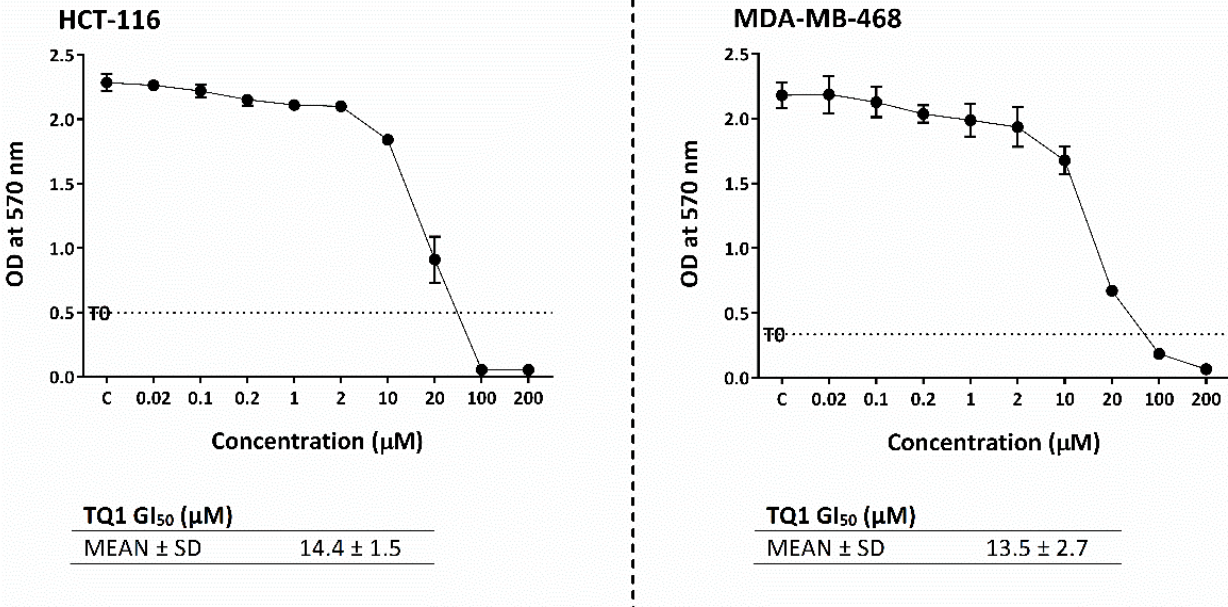
Figure 12. Growth-inhibitory effects of TQ1 in MDA-MB-468 and HCT-116. Each representative graph shows one inde- pendent MTT trial. Cells were seeded in 96-well plates (3 × 10 3 cells/well) and treated with TQ1 for 72 h. No. trials ≥3; n = 4 per independent experiment.